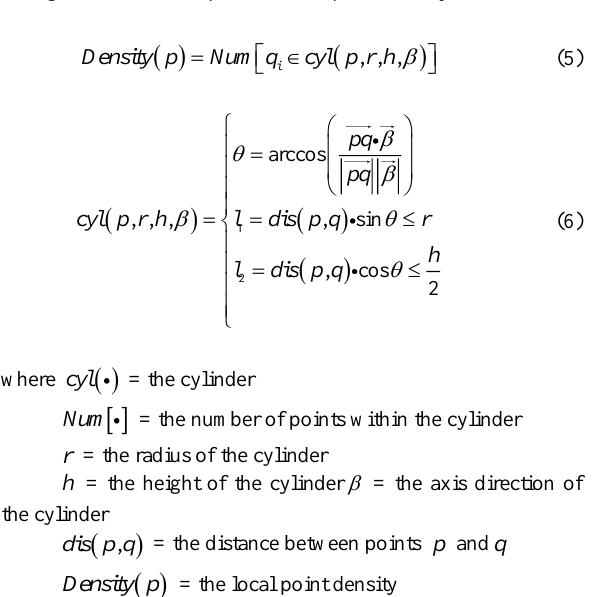
Figure 5. Sketch map of the local point density